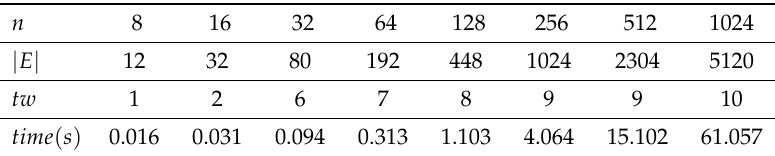
Table 2. Experimental results of the induced graphs of CP-nets.